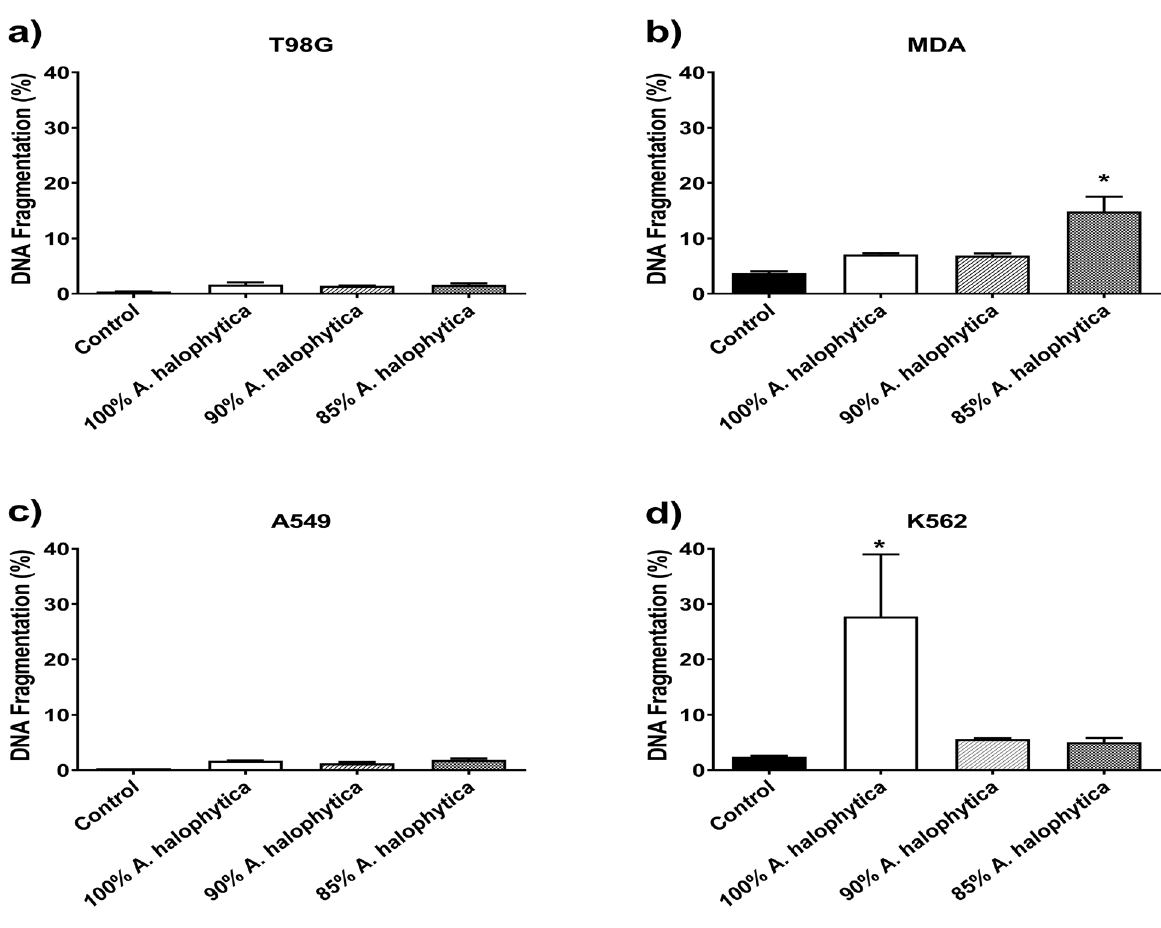
Figure 2. DNA fragmentation induced by Aphanothece halophytica extract. T98G (a), MDA231(b), A549(c) and K562(d) cells cultured with extracts of cyanobacteria after 72 hours with their highest concentration [1000µg/mL]. Representative result of flow cytometry experiment considering a minimum of 10,000 events, being the mean ± standard deviation. Two-way ANOVA with Dunnett‘s post-test relative to control; * P